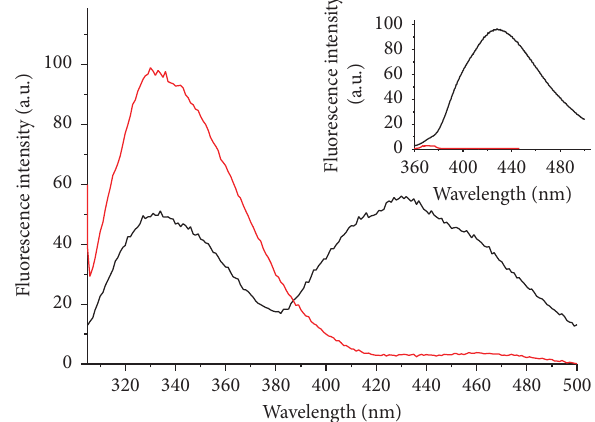
Figure 2: Fluorescence spectra of 0.10mg/mL AlDHPyr1147 at room temperature: AlDHPyr1147 as isolated (black line), the same enzyme after heating up to 85 ∘ C and subsequent cooling to room temperature (red line). The excitation is at 297 and 330nm (in the